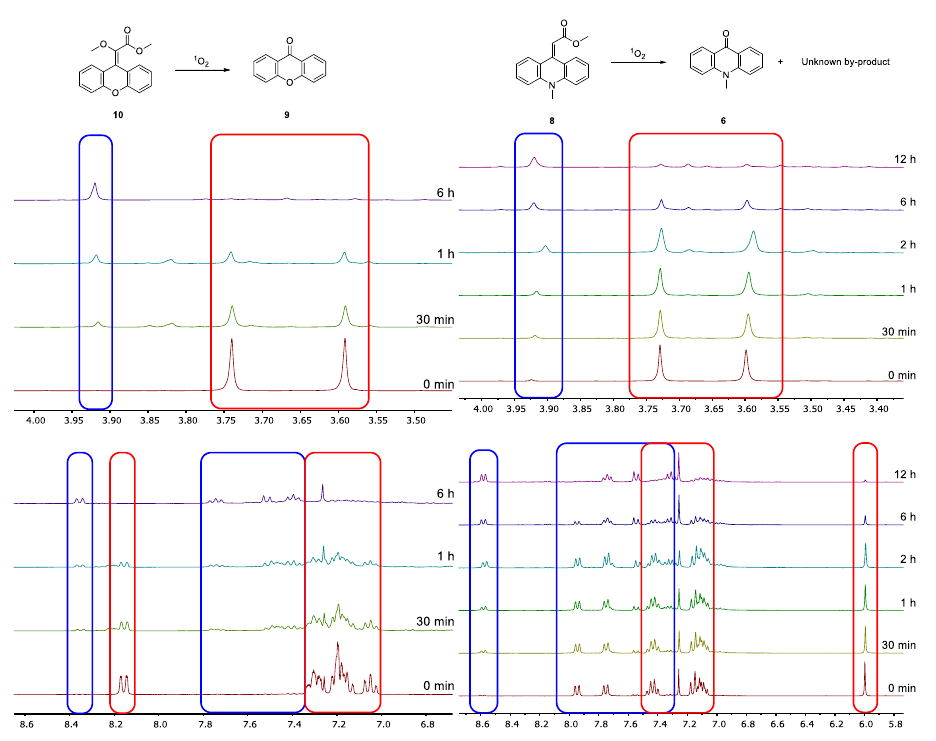
Figure 3. NMR time traces of photooxygenation experiment: xanthone-derived substrate ( 10 ) ( left ); acridone-derived substrate ( 8 ) ( right ). Blue boxes = increase of signal intensity; red boxes = decrease of signal intensity.